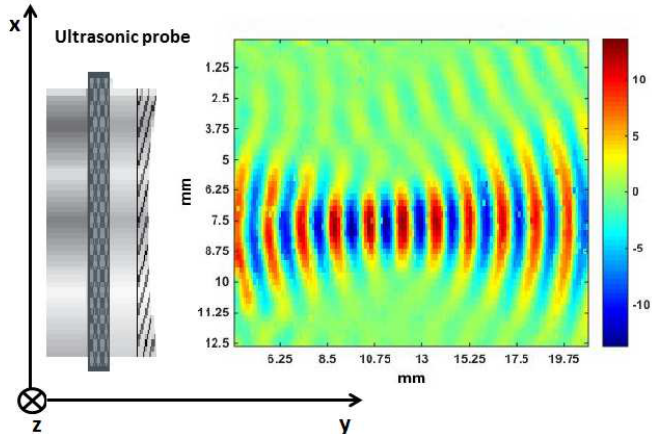
Laser Doppler vibrometry (LDV) visualization of the focused transducer Panametrics V303 for the frequency of 1 MHz. The ultrasonic probe is located on the left of the first measured